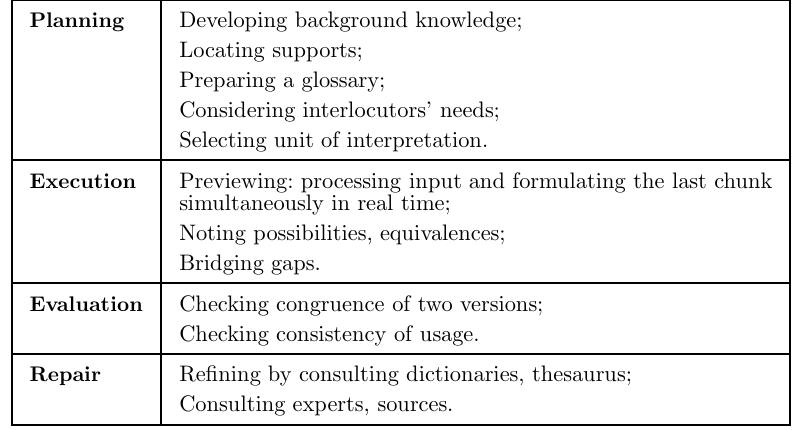
Figure 2. Steps in mediation (CEFR